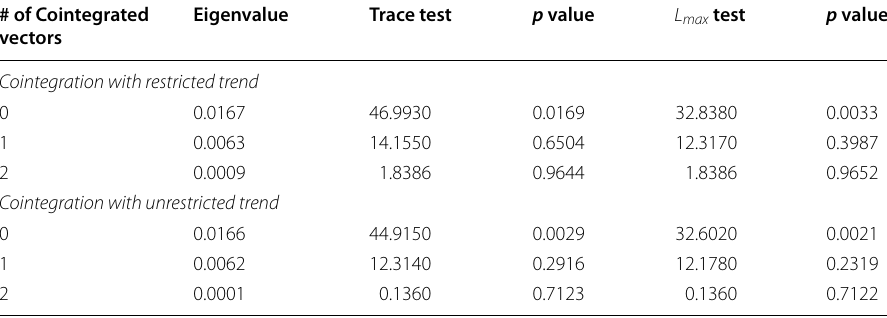
Table 3 Results of the Johansen cointegration tests